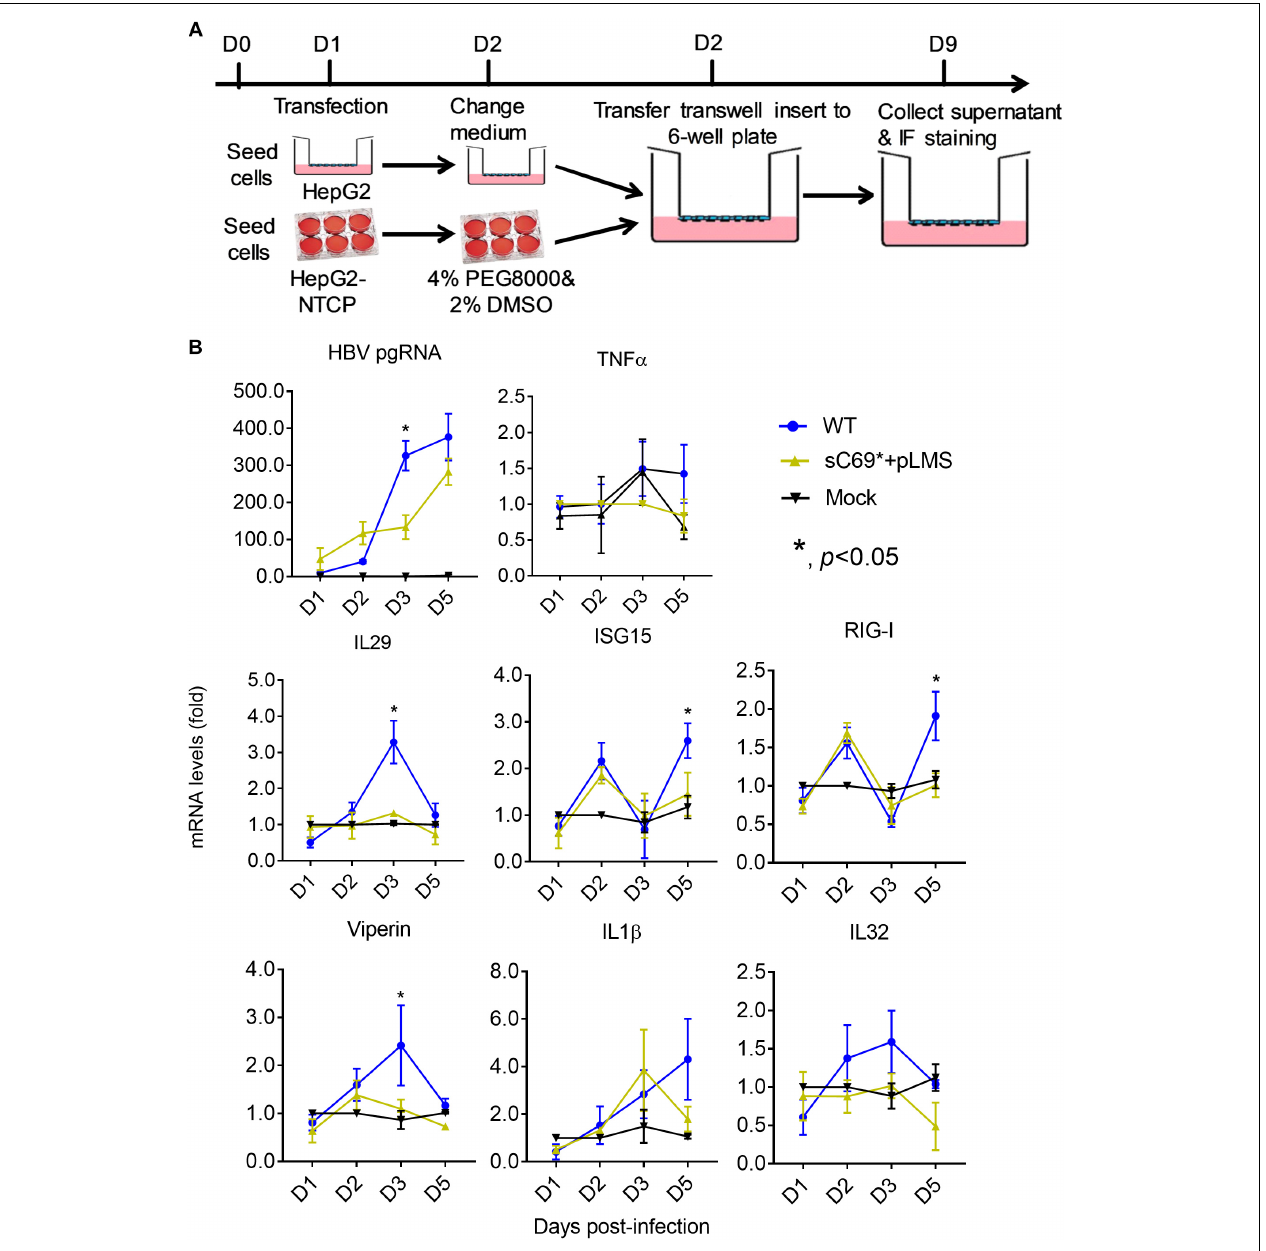
FIGURE 2 | The sC69 ∗ mutant inhibits host innate immune response compared to HBV WT in HepG2-NTCP cells. (A) HepG2 cells seeded in the insert of trans -well were transfected with HBV WT and sC69 ∗ + pLMS, respectively. The next day, the inserts were transferred to wells with HepG2-NTCP cells. The cells were harvested at days 1, 2, 3, and 5 post-infection. (B) HBV pgRNA and innate immunity related mRNAs (TNF α , IL29, ISG15, RIG-I, viperin, IL1 β , and IL32) were detected after the infection of HBV virions from transfection system. Data from three biological replicates are shown as means ± s.d. Statistical analysis was performed by a Student’s t -test ∗ p <